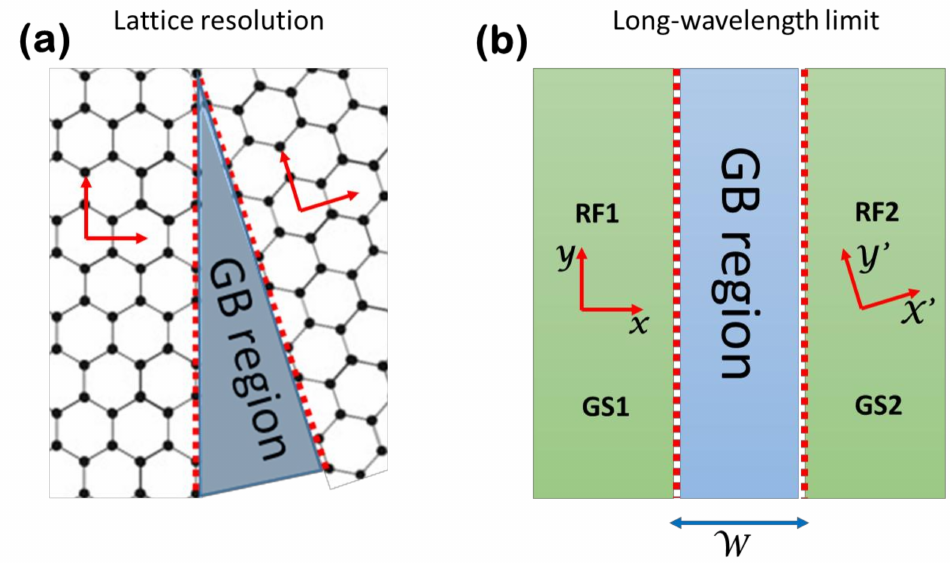
Figure 1. ( a ) Schematic of the region close to a grain boundary (GB region). Apart from the grain boundary region, where lattice distortions and vacancies affect the honeycomb lattice structure of graphene, the bulk of the system is described by a regular atomic arrangement in which the lattice orientation is subject to a rotation of a definite angle going from the left to the right side of the junction. ( b ) The long wavelength limit of the grain boundary junction depicted in panel ( a ). The graphene sheets 1 and 2, namely GS1 and GS2, represent the two sides of the junction, while the GB region is represented by a region of negligible extension W , whose effects on the scattering properties of the junction are captured by appropriate boundary conditions. The boundary conditions are a direct manifestation of the presence of a grain boundary effective potential U ( x ) . The presence of the GB imposes a lattice rotation of the GS2 compared to the GS1. This effect is easily described using distinct local reference frames, RF1 and RF2, in describing the two sides of the system. Translational invariance along the y-direction of the RF1 is